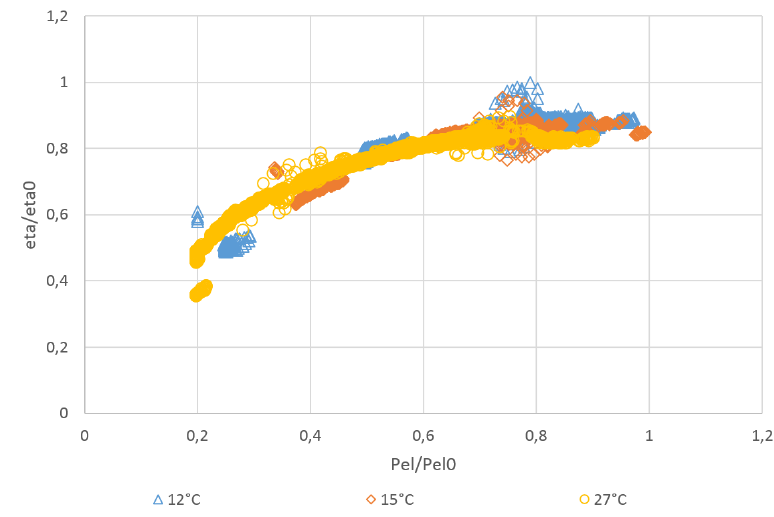
Figure 4. Variation of efficiency as a function of electric load and ambient temperature.